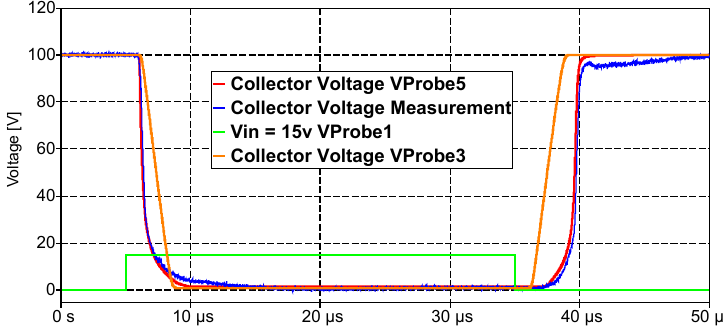
Figure 20. Collector and gate voltages with R1 = R2 = 50 Ohm (Figure 19).